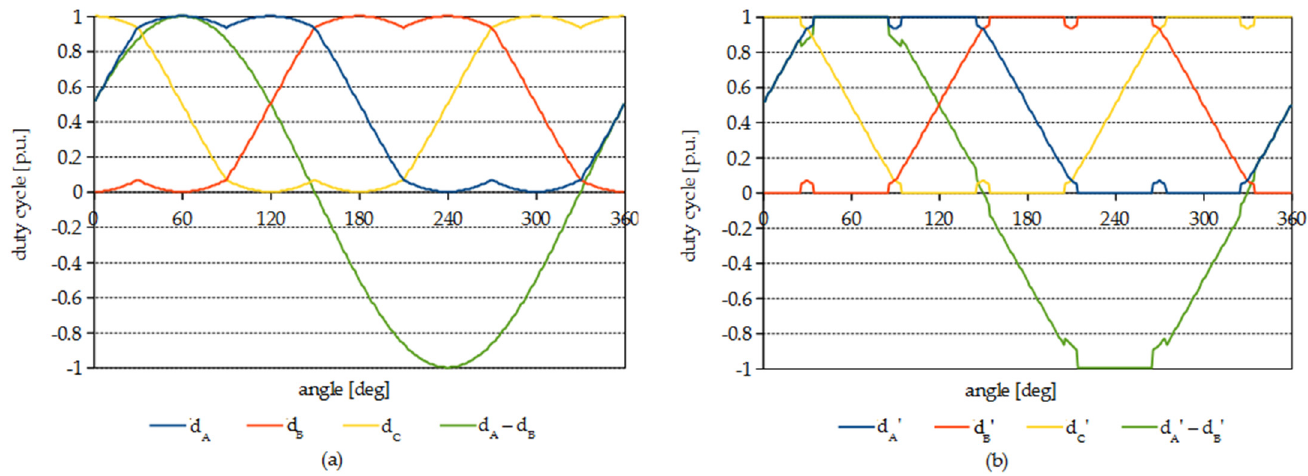
Figure 4. SVPWM modulation ( a ) linear mode and ( b ) deformed modulation with 5% pulse limitation.